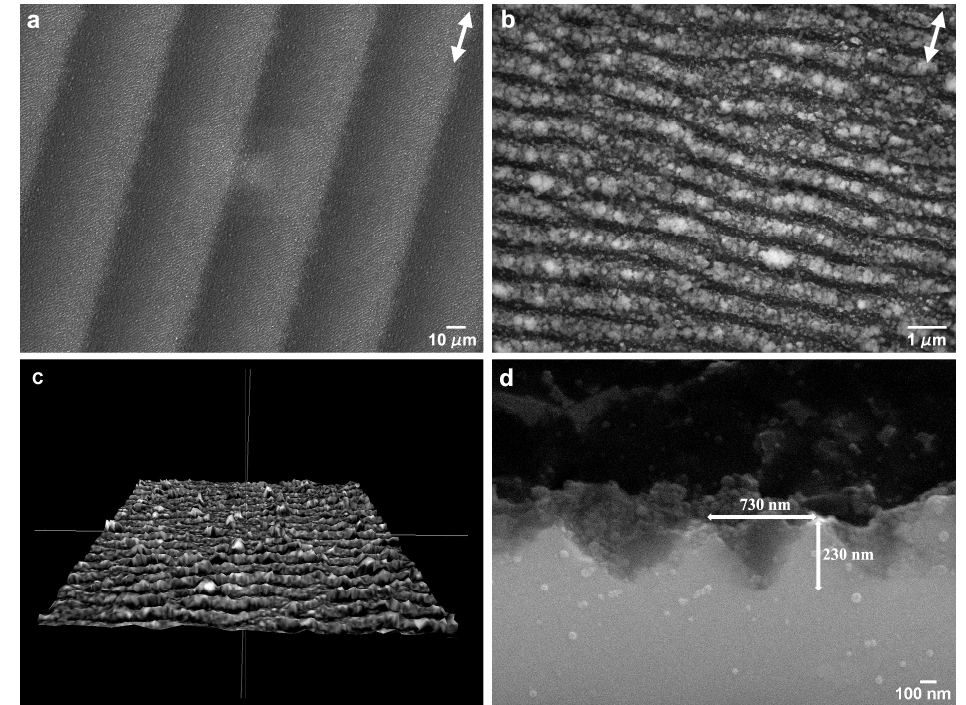
Figure 1. ( a ) SEM micrograph of a silicon surface textured with laser-induced periodic surface structures (LIPSS); ( b ) higher magnification image; ( c ) 3D surface reconstruction of the textured surface; ( d ) SEM micrograph of the cross-section of the LIPSS. The double arrows in ( a , b ) indicate the beam polarization direction.